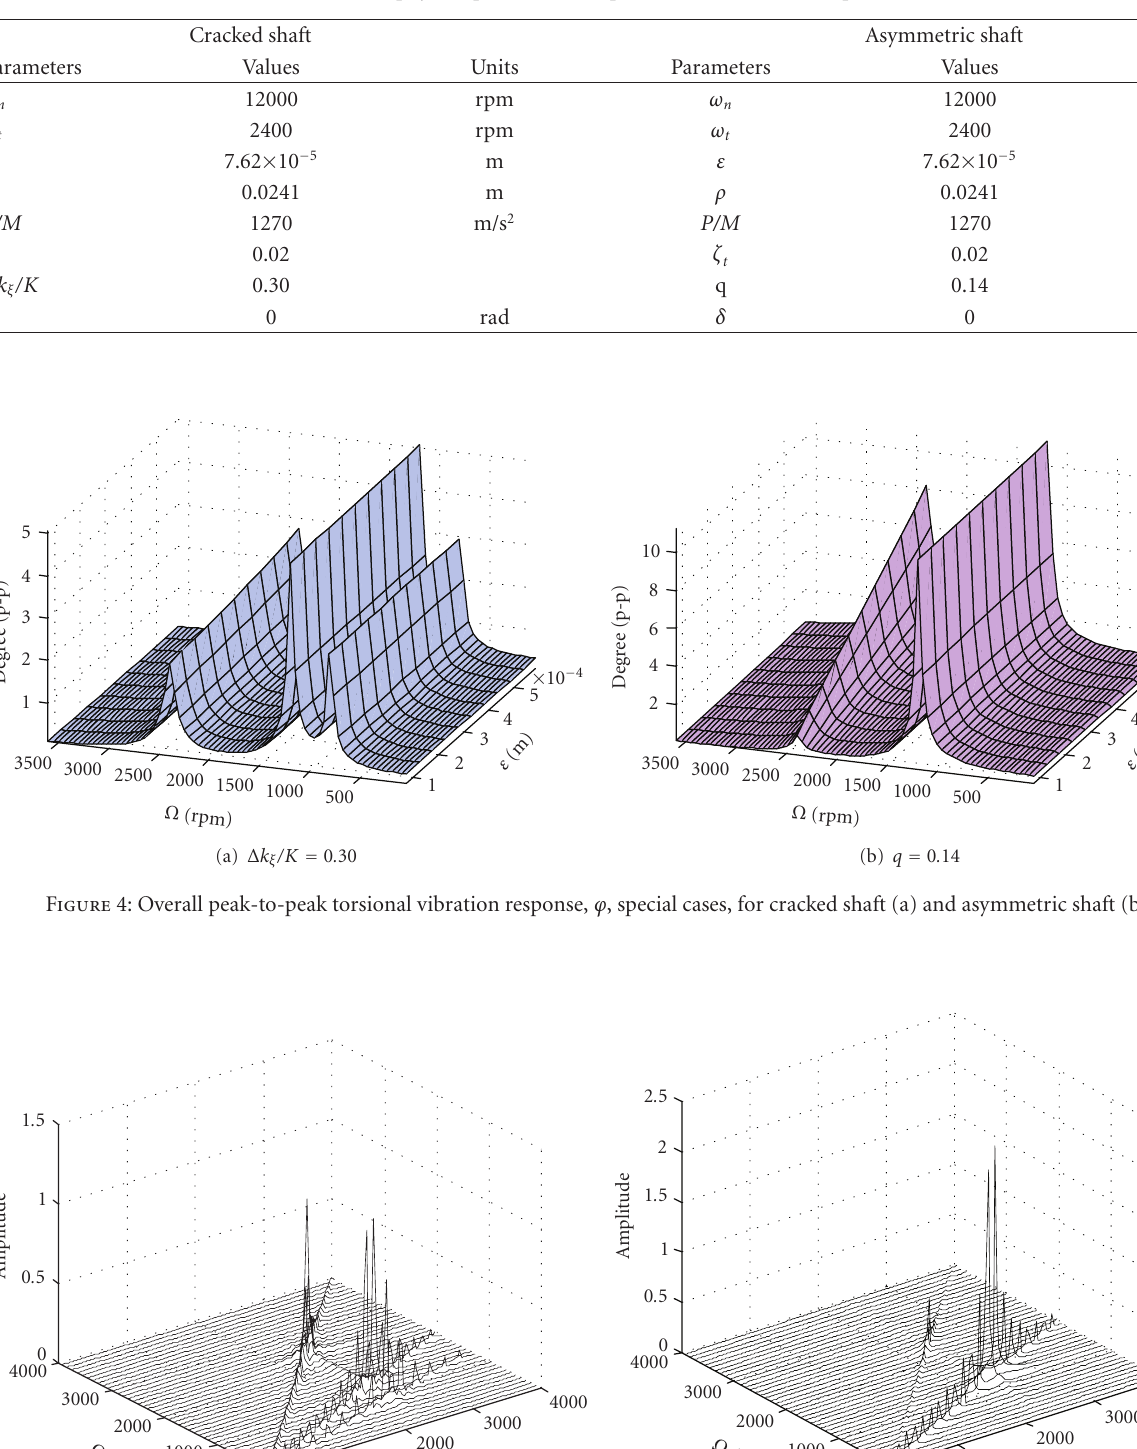
Table 1: Model physical parameters for pure torsional vibration, special cases.